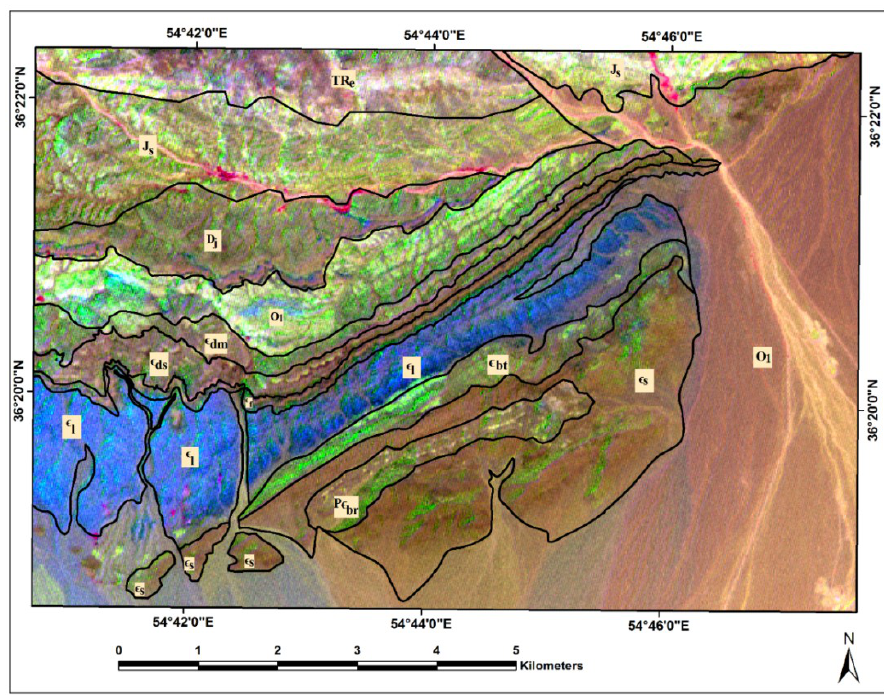
Figure 8. RGB Color composite of BRTM PC1, PC2, PC3 for the Deh-Molla region. Qal, Quaternary alluviums; Js, Shemshak Formation; TRe, Elika Formation; Dj, Jeirud Formation; Ol, Lashkarak Formation; Єdm, Deh-Molla Formation; Єds, De-Sufian Formation; Єf, Fasham; Єl, Lalun; Єz, Zagun Formation; Єbt, Barut Formation; Єs, Soltanieh Formation; PЄbr, Bayandor Formation.